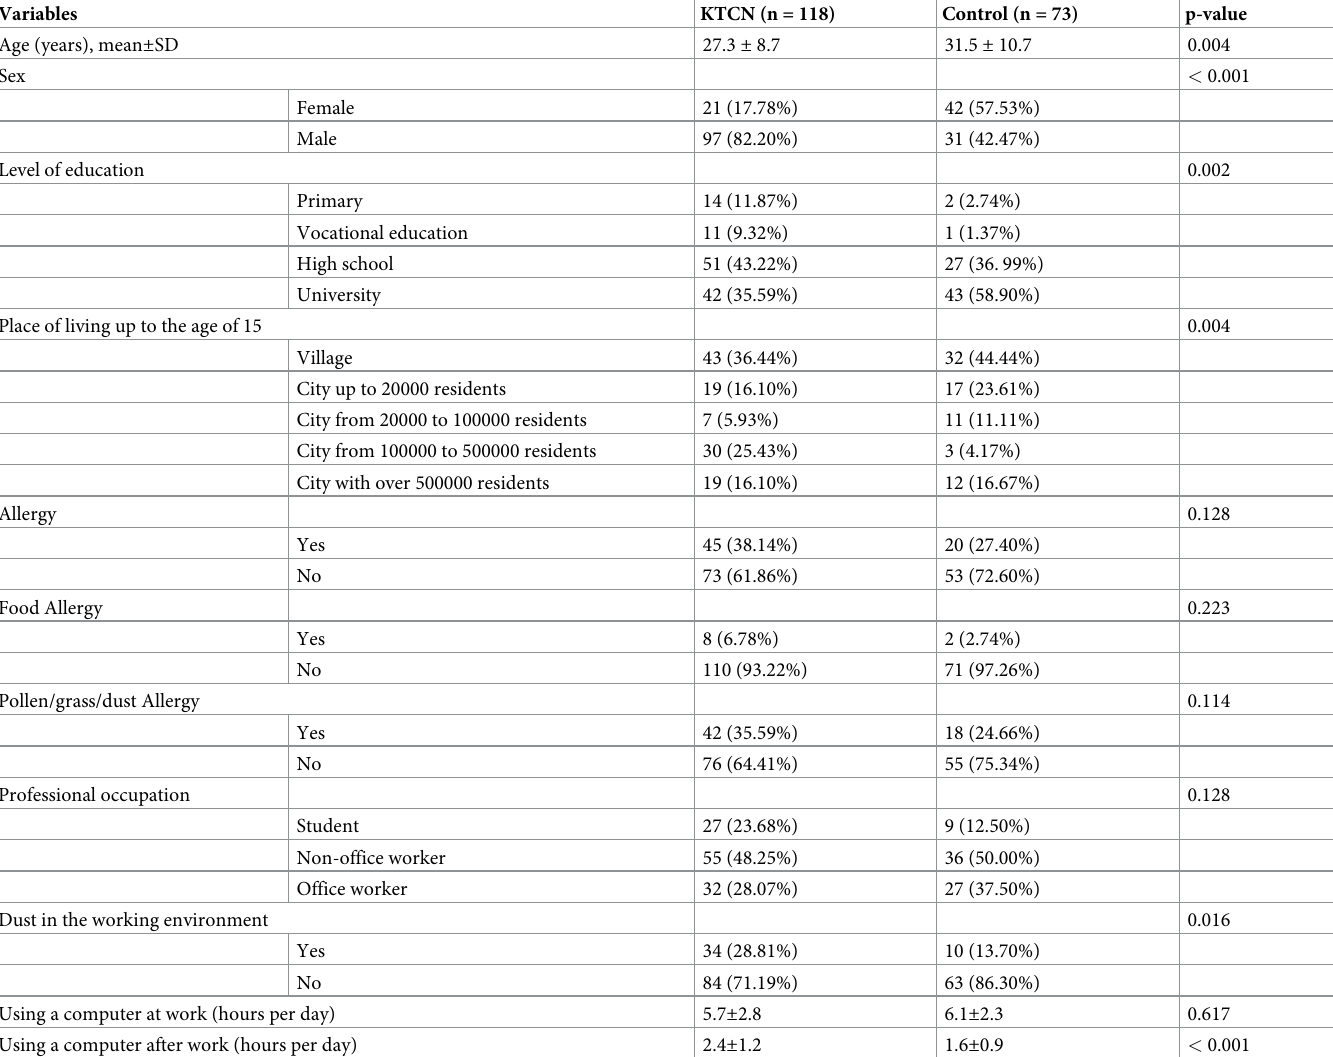
Table 2. Qualitative and quantitative data/results of analyzes of selected behavioral, environmental, and socioeconomic aspects. Variables